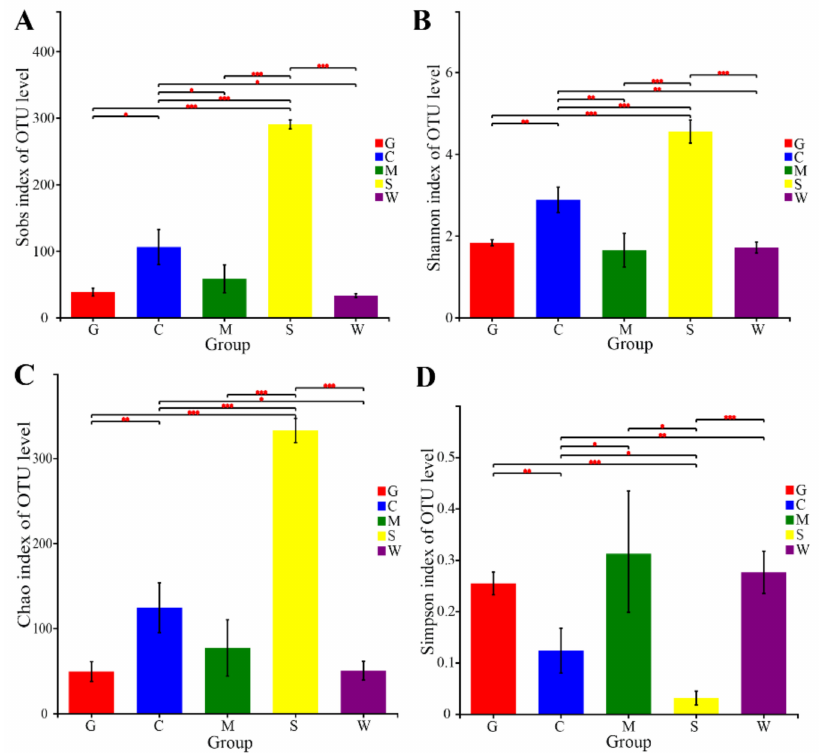
Figure 1. Comparison of alpha diversity indices of the bacterial communities at different sites. ( A ) Comparison of the Sobs index of the bacterial communities at different sites, ( B ) comparison of the Shannon index of the bacterial communities at different sites, ( C ) comparison of the Chao index of the bacterial communities at different sites, and ( D ) comparison of the Simpson index of the bacterial communities at different sites. Higher Sobs and Chao values indicate a higher richness; higher Shannon and lower Simpson values indicate a higher diversity. Statistical significances between two sites were considered at * p < 0.05, ** p < 0.01, and *** p < 0.001 by Welch t -test. G: gill mucosae (G1–G4); C: intestinal contents (C1–C4); M: intestinal mucosae (M1–M4); S: stomach contents (S1–S4); W: stomach mucosae